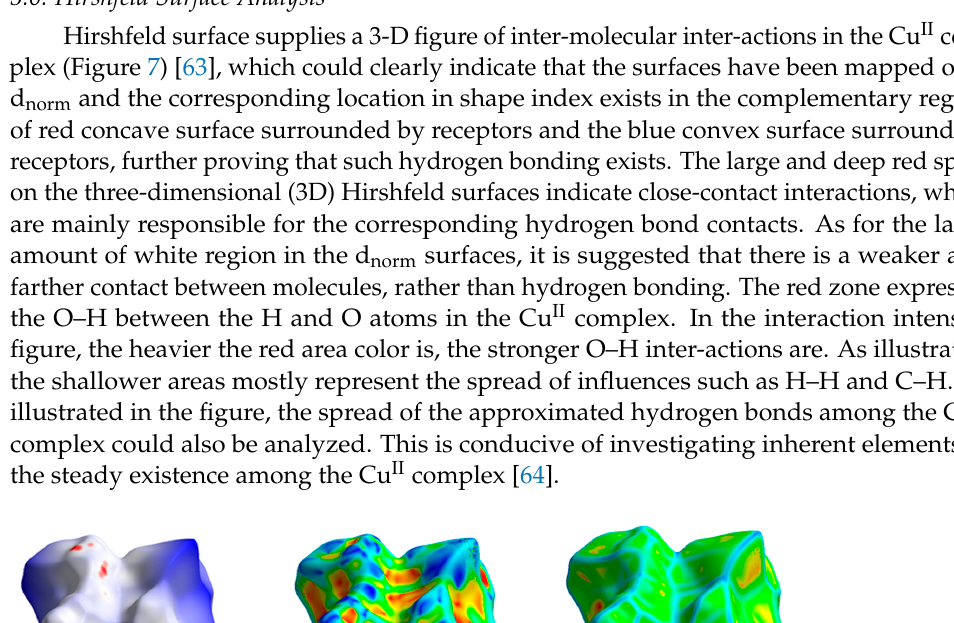
Figure 7. Hirshfeld surfaces analyses mapped with ( a ) d norm , ( b ) shape index, and ( c ) curvedness of the Cu II complex.